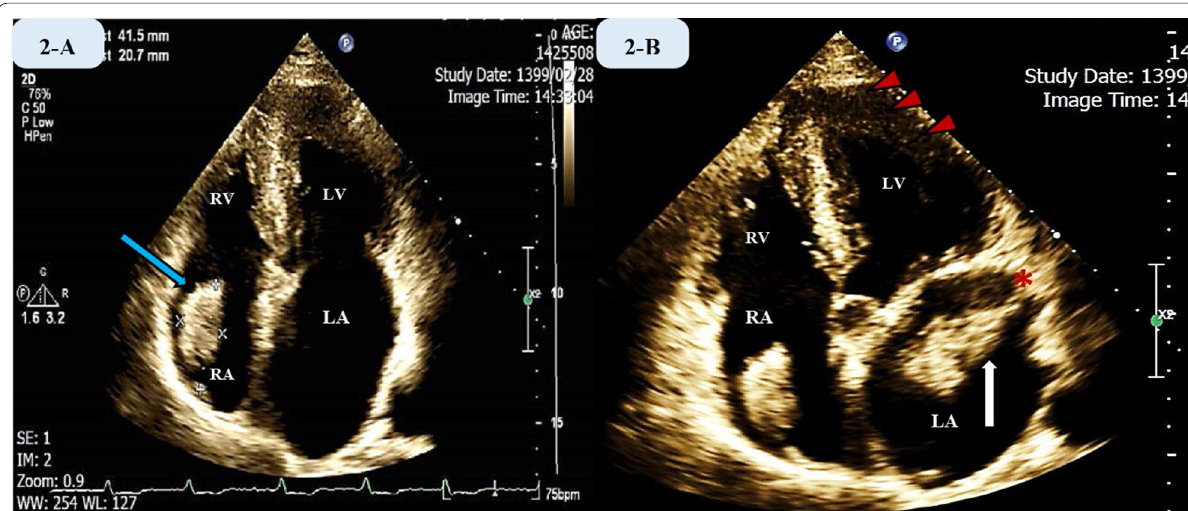
Fig. 2 Transthoracic echocardiographic images showing two large atrial masses as well as extreme LA dilatation. A Apical four‑chamber view illustrating a large pedunculated homogenous, well‑demarcated mass with 42 mm*21 mm dimensions attached to right atrial appendage (indicated via a blue oblique arrow). B Apical five‑chamber view showing concomitant presence of two atrial masses. The vertical white arrow points to a large lobulated mass in LA with well‑defined borders attached to LAA (red asterisk) with a stalk. Red arrowheads depict the apical to mid ventricular extension of hypertrophy. LV: left ventricle, RV: right ventricle, LA: left atrium, RA: right